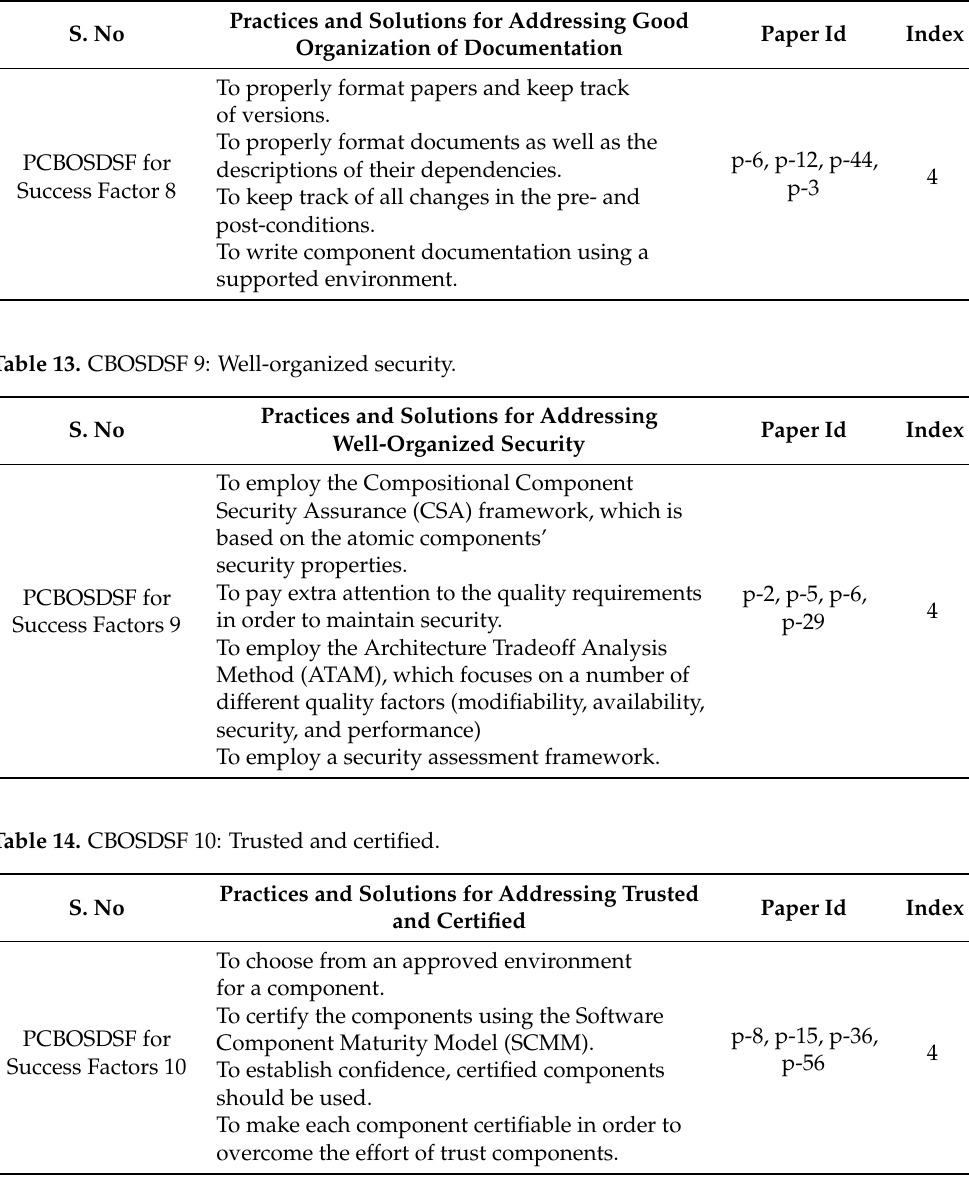
Table 12. CBOSDSF 8: Good organization of documentation.